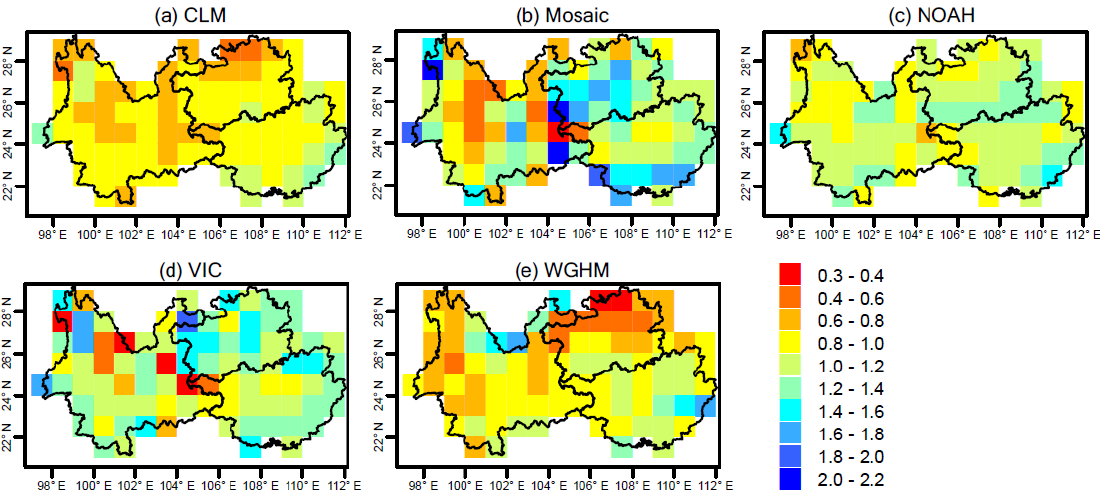
Figure 5. Gridded scaling factors derived using different model simulations as the a priori information. The 0.5° × 0.5° WGHM data are resampled to 1° × 1° as GLDAS models.